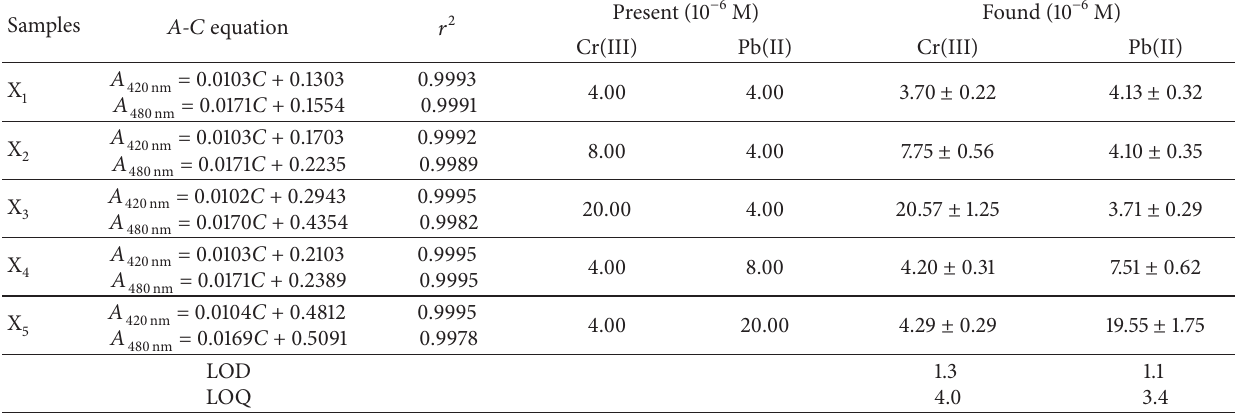
Table 1: Results obtained by the HPSMA for the analysis of Cr(III) and Pb(II) mixtures in different concentrations. Samples